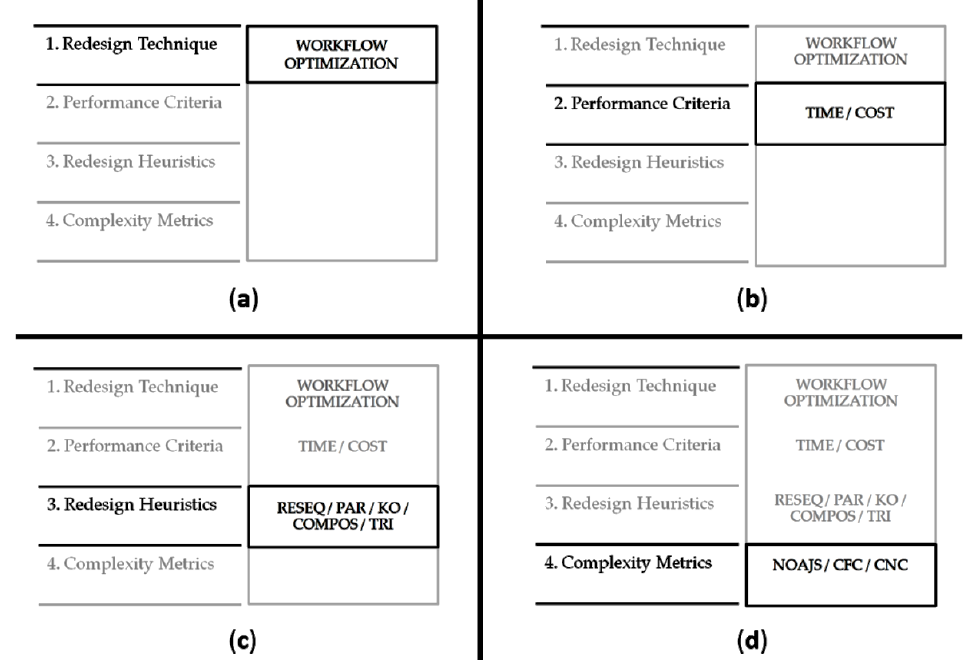
Figure 2. Selection Phase of: ( a ) redesign technique; ( b ) performance criteria; ( c ) redesign heuristics; ( d ) complexity metrics.